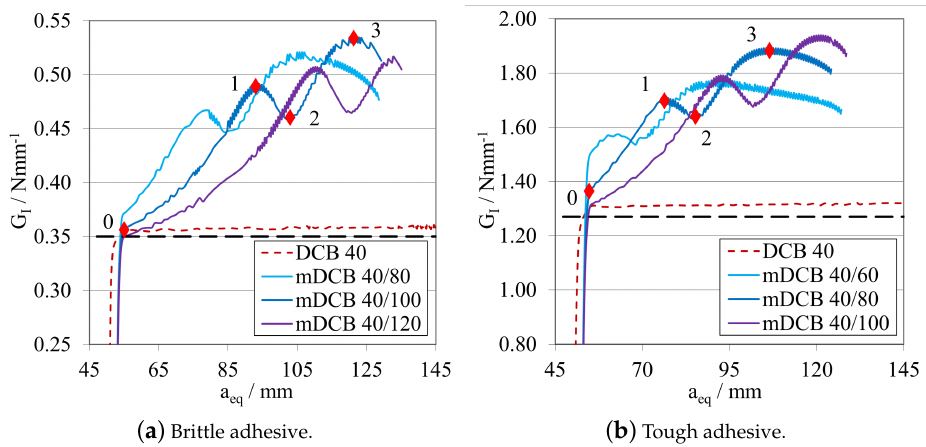
Figure 19. R-curves related to a 0 ELS > a 0 mDCB , compared against the correspondent standard DCB. Black dashed line represents the input G IC value. Auxiliary red markers represent the stages of crack evolution for the intermediary dark blue